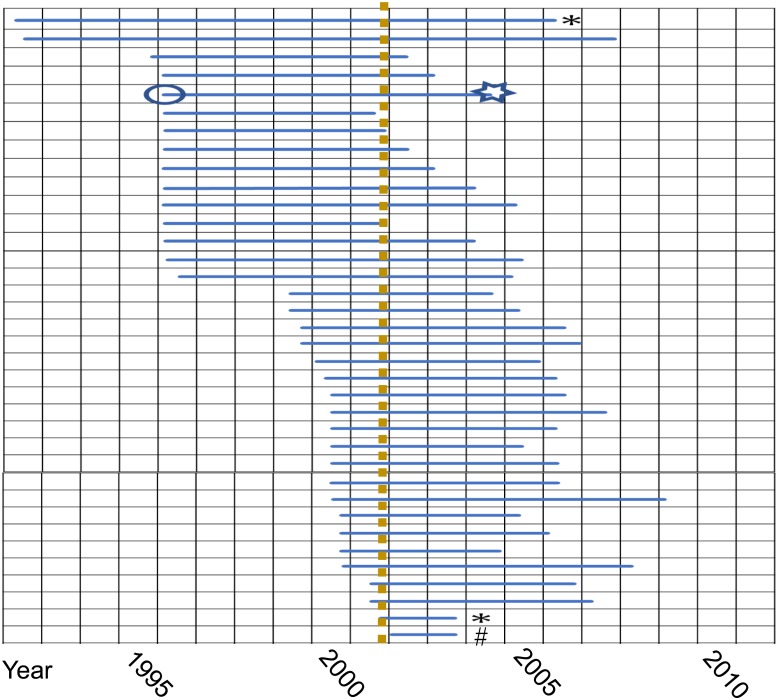
Individual BSE cases confirmed in Japan.Each horizontal bar () indicates the period between the birth and death
(including slaughter) of each case.: Birth,: Death, *:L-BSE case, #: The brain tissue has no infectivity to Tg mice overexpressing bovine PrP.: The time of the ban of manufacturing and sale of the feed for livestock
con